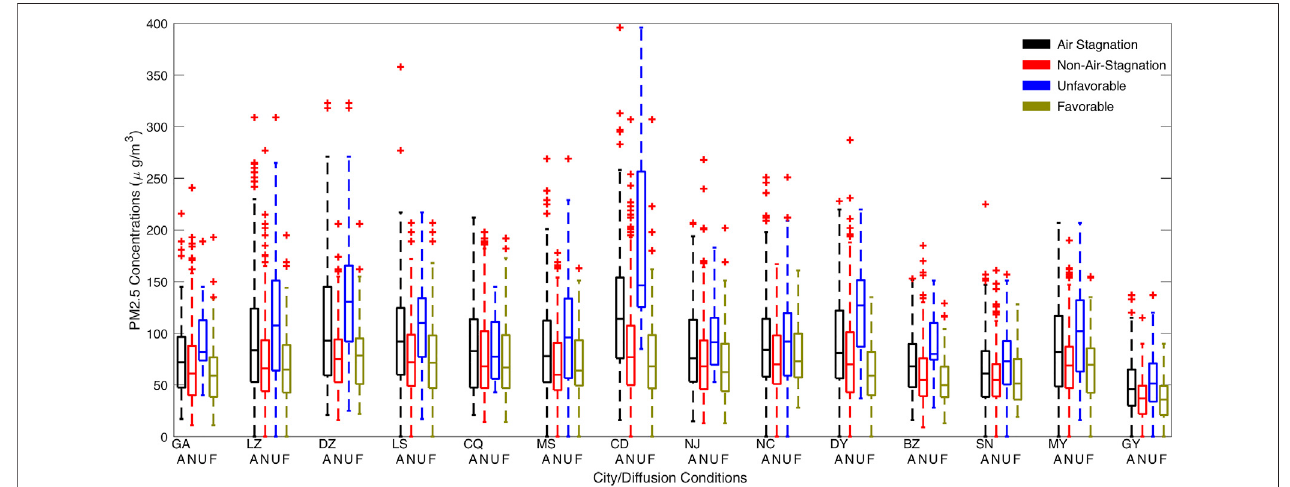
FIGURE 6 | Box plot of daily mean PM2.5 concentrations according to different metrics of atmospheric diffusion conditions in the speci fi c cities. Abbreviations of the 14 cities are the same as in Figure 1 . Labels of A/N/U/F in the X -axis indicate air stagnation, no-air-stagnation days, and unfavorable and favorable conditions,